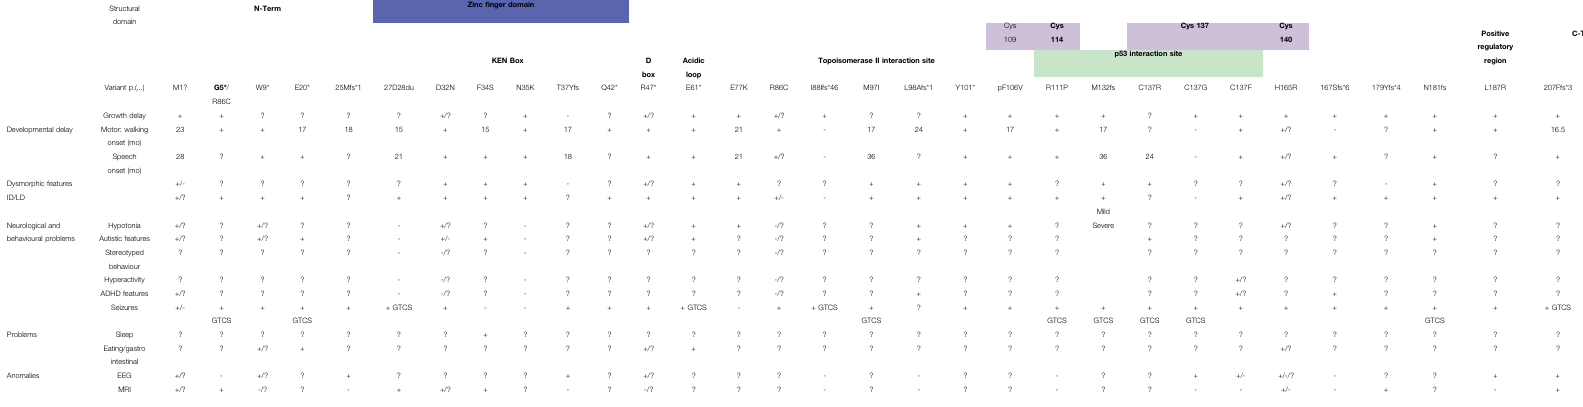
All patients whose symptoms were published thus far are ordered by the position of their amino acid alteration, from left to right: N-terminus to the C-terminus. Patients with the same variant are grouped in one column. “ + ” indicates that symptomispresent, “ − ” thatitisabsent, “ +/ − ” isusedwhenpatientsweredescribedwhohadorhadnotthespeci fi cphenotype, “ ? ” isusedwhenthespeci fi cphenotypewasnotdiscussedinthecorrespondingpublication.Whenpossible, age indications (in months) for symptom onset/detection are given. Abbreviations: ATP: adenosine triphosphate; GTP: guanosine triphosphate; ID: intellectual disability; LD: learning disability; ADHD: attention de fi cit hyperactivity disorder; GTCS: generalized tonic-clonic seizure; GERD: gastroesophageal re fl ux disease; G-tube: Gastrostomy tube; EEG: electroencephalography; MRI: Magnetic resonance imaging. For more details, Supplementary Table S2 . Information derived from (Sakaguchi et al., 2017; Li et al., 2019; Nakashima et al., 2019; Bonanni et al., 2021; Ernst et al., 2021; Wilke et al.,